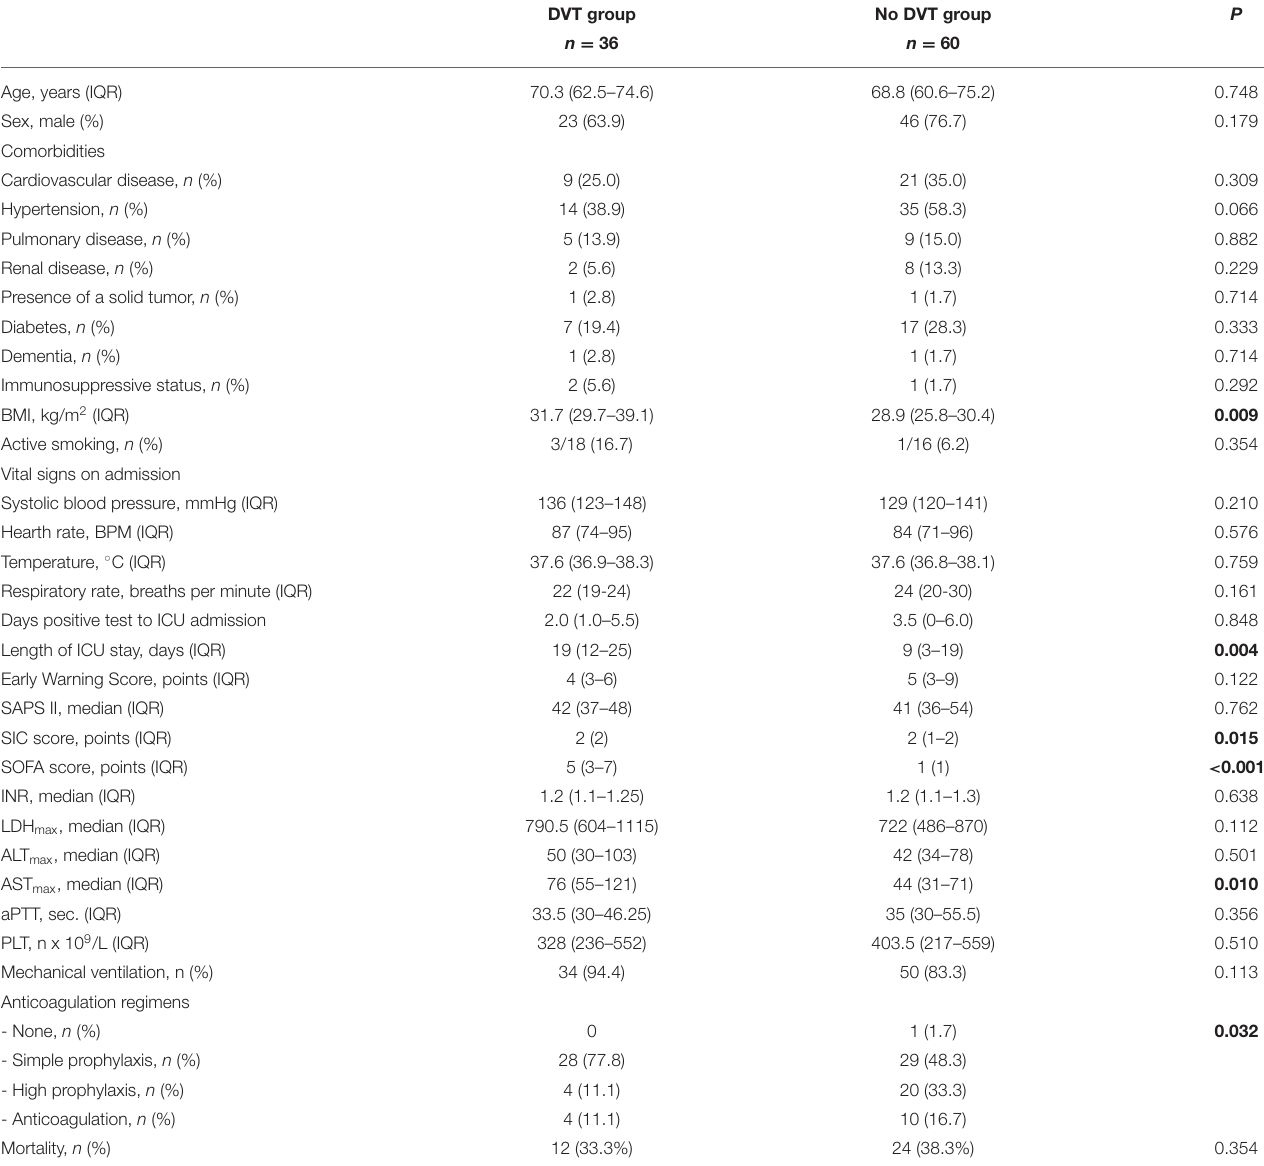
TABLE 3 | Patient characteristics and primary clinical